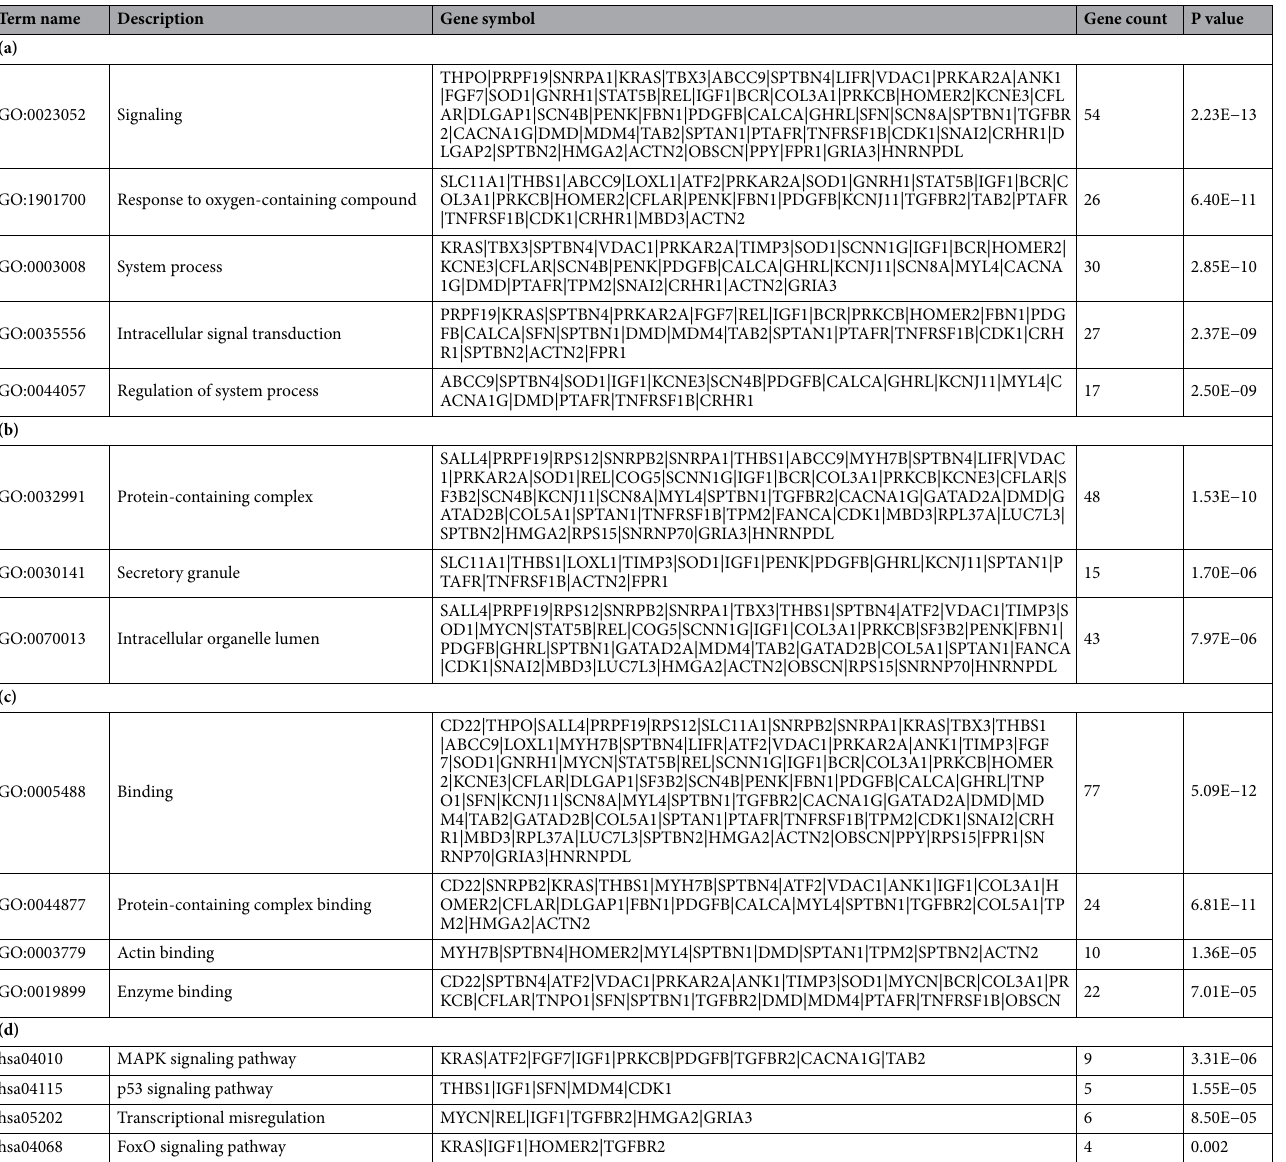
Table 2. Gene ontology and KEGG analysis of differentially expressed genes associated with SOD1 in recurrent spontaneous abortion: (a) biological process (b) cellular component (c) molecular function (d) KEGG